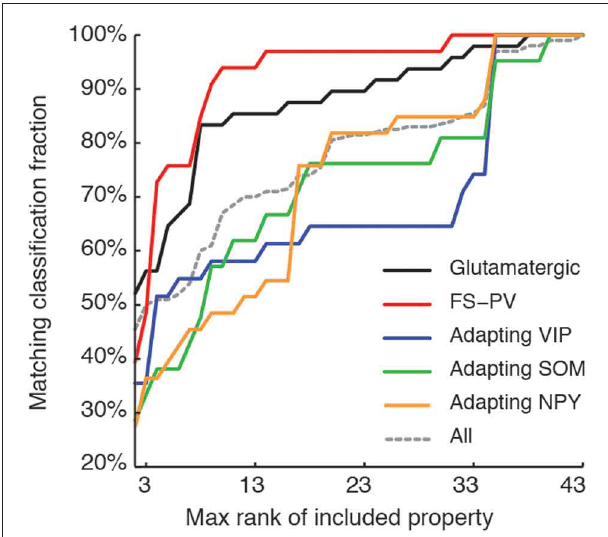
FIGURE 7 | Relevance of features for classification. Matching between classifications based on a reduced number of top-ranked properties with the reference classification based on all the 43 features (see Table 7 for relevance ranking of the different properties). Classification matching is analyzed separately for every well-defined archetype and is measured by the fraction of cells with a given main type, matching in both the reference, and a reduced classification. Matching classification fraction for all archetypes confounded is also shown for comparison. Note the order of correctly classified archetypes corresponding to the historically characterized neuronal